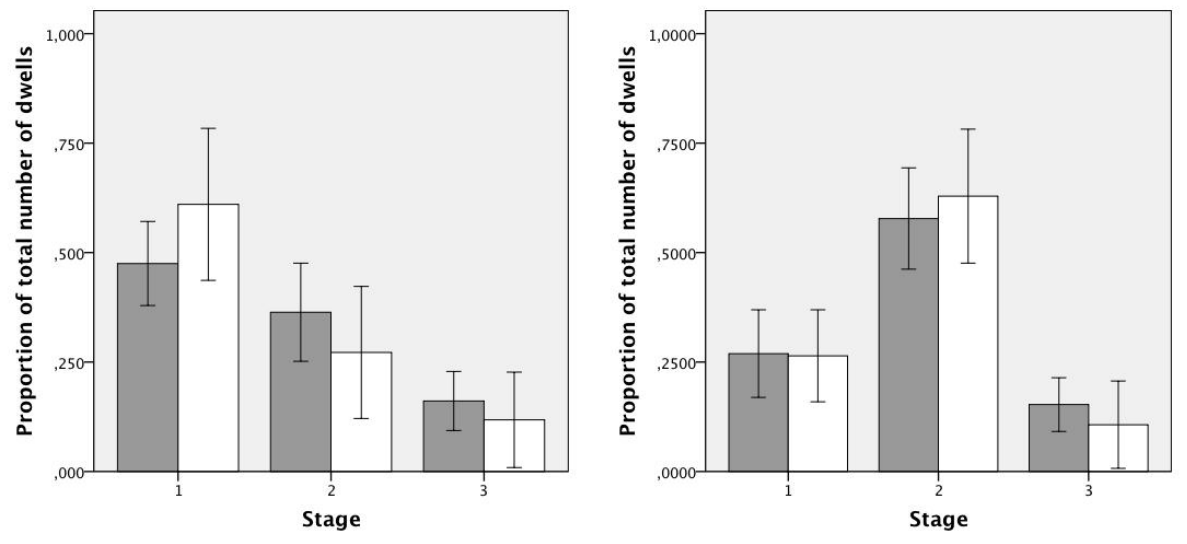
Figure 4. Proportion of total number of dwells, the Natural Decision Segmentation Model on the left, Russo and Leclerc (1994) version on the right. Grey bars represent decision task and white bars represent search task. Error bars +/- 2 SE.